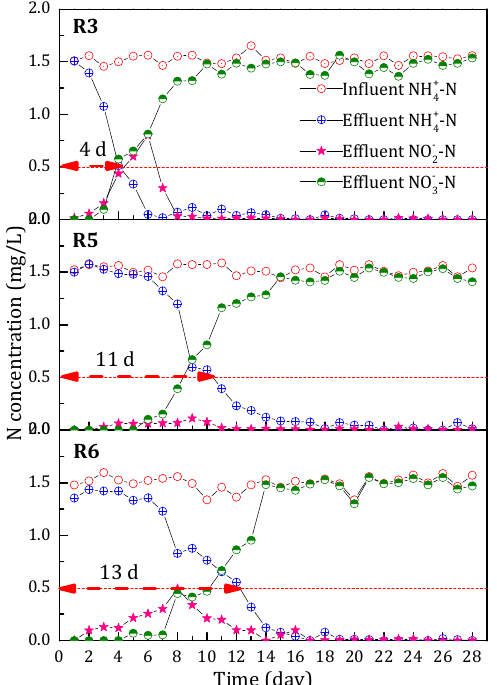
Figure 6. The effect of influent Mn concentration and filtration rate on the variation of N (NH 4+ -N, NO 3 − -N and NO 2 − -N) concentration during the start-up period.